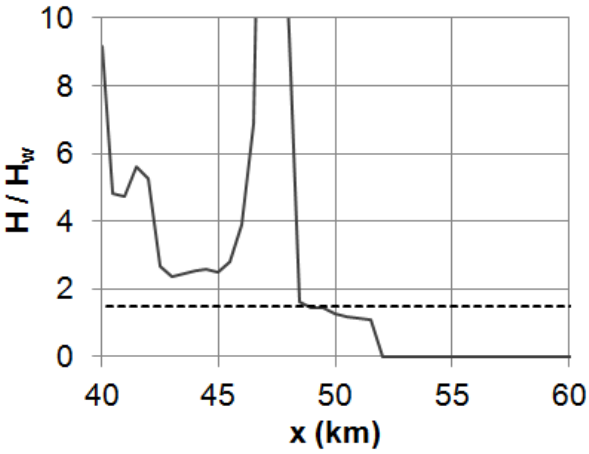
Fig. 4. The ratio between observed ice thickness ( H) and wa- ter depth ( H w ) along the main flowline of Columbia Glacier in 2007 (McNabb et al., 2012). Tidewater terminus geometry may be regarded as stable when H / H w ≥ 1 . 5 and unstable when H / H w < 1.5 (Pfeffer, 2007).